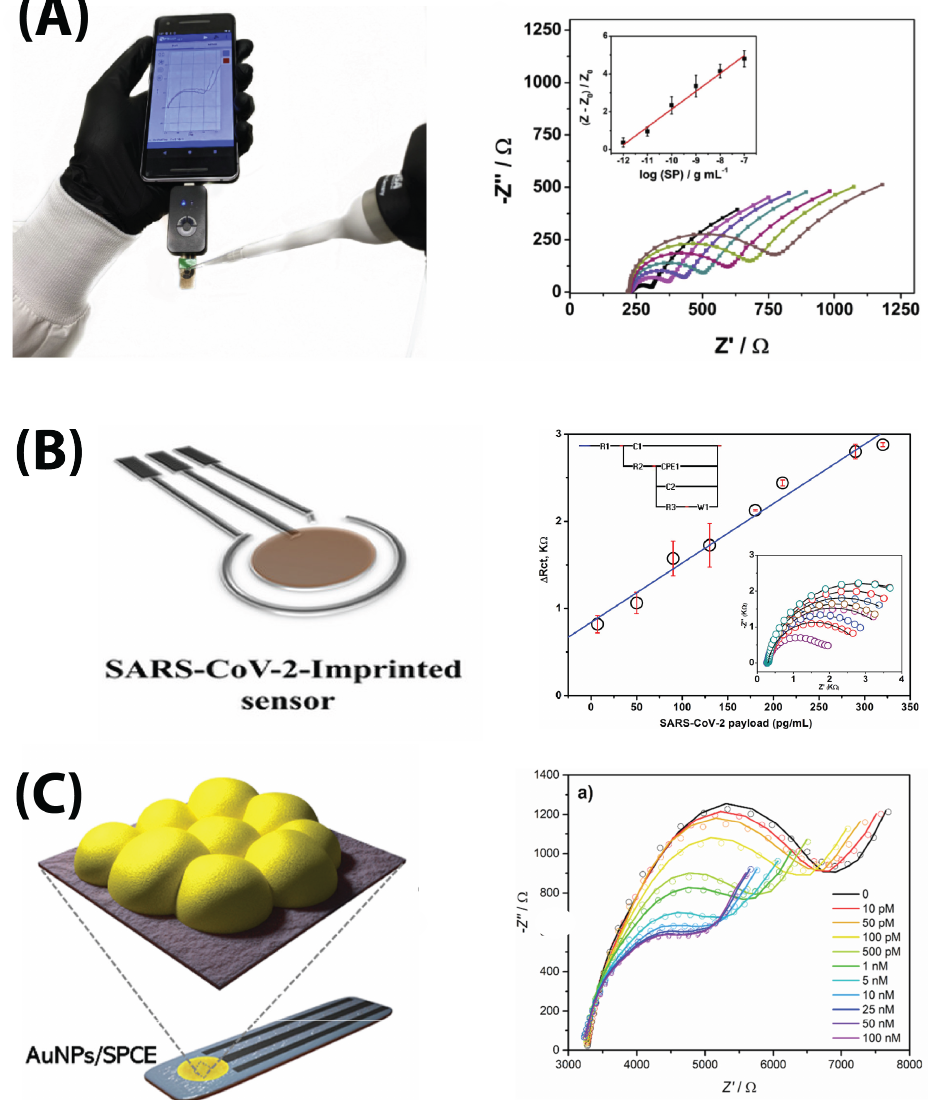
Figure 8. A selection of fully integrated EIS sensors for COVID-19. ( A ) A paper-based